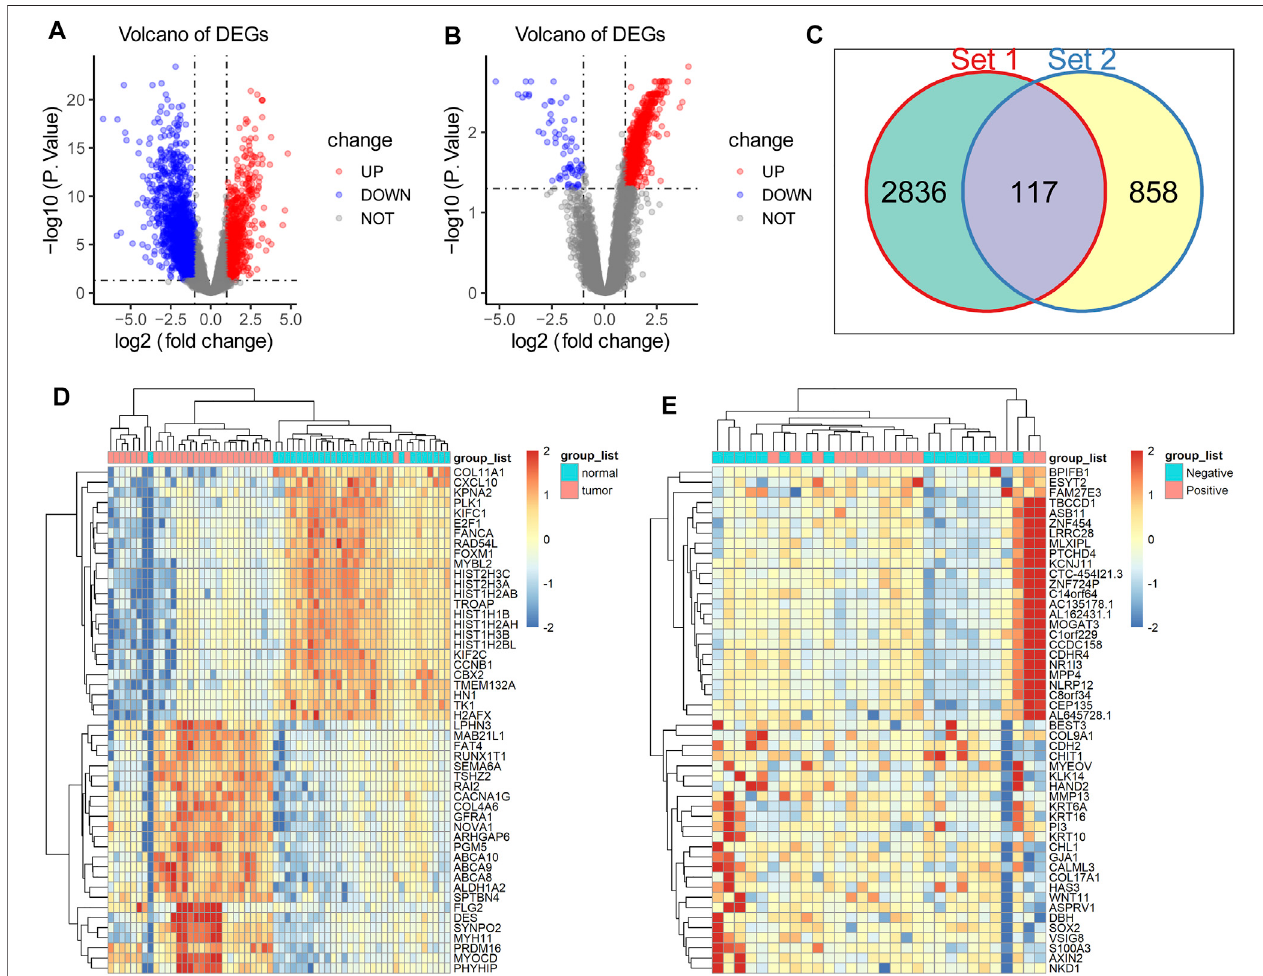
FIGURE1| AcquisitionofDEGsinTNBC. (A) Therewere2,953DEGsbetweennormalandcanceroustissue,including981upregulatedDEGs(reddots)and1972 downregulated genes (blue dots). (B) There were 975 DEGs between TNBC with lymph node metastasis and TNBC without lymph node metastasis, including upregulated 905 DEGs (red dots) and 70 downregulated genes (blue dots). (C) There were 117 overlapping DEGs between the above two gene sets. (D) Heatmap anaysisshowedadistinctgeneexpressionpatternbetweencanceroustissueandmatchednormaltissue. (E) Heatmapanalysisshowedadistinctgeneexpression pattern between TNBC with lymph node metastasis and TNBC without lymph node metastasis.